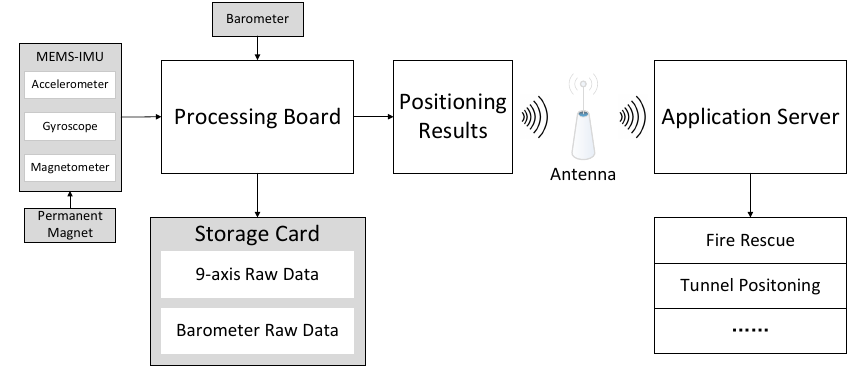
Figure 25. Hardware structure of the 3D positioning system.